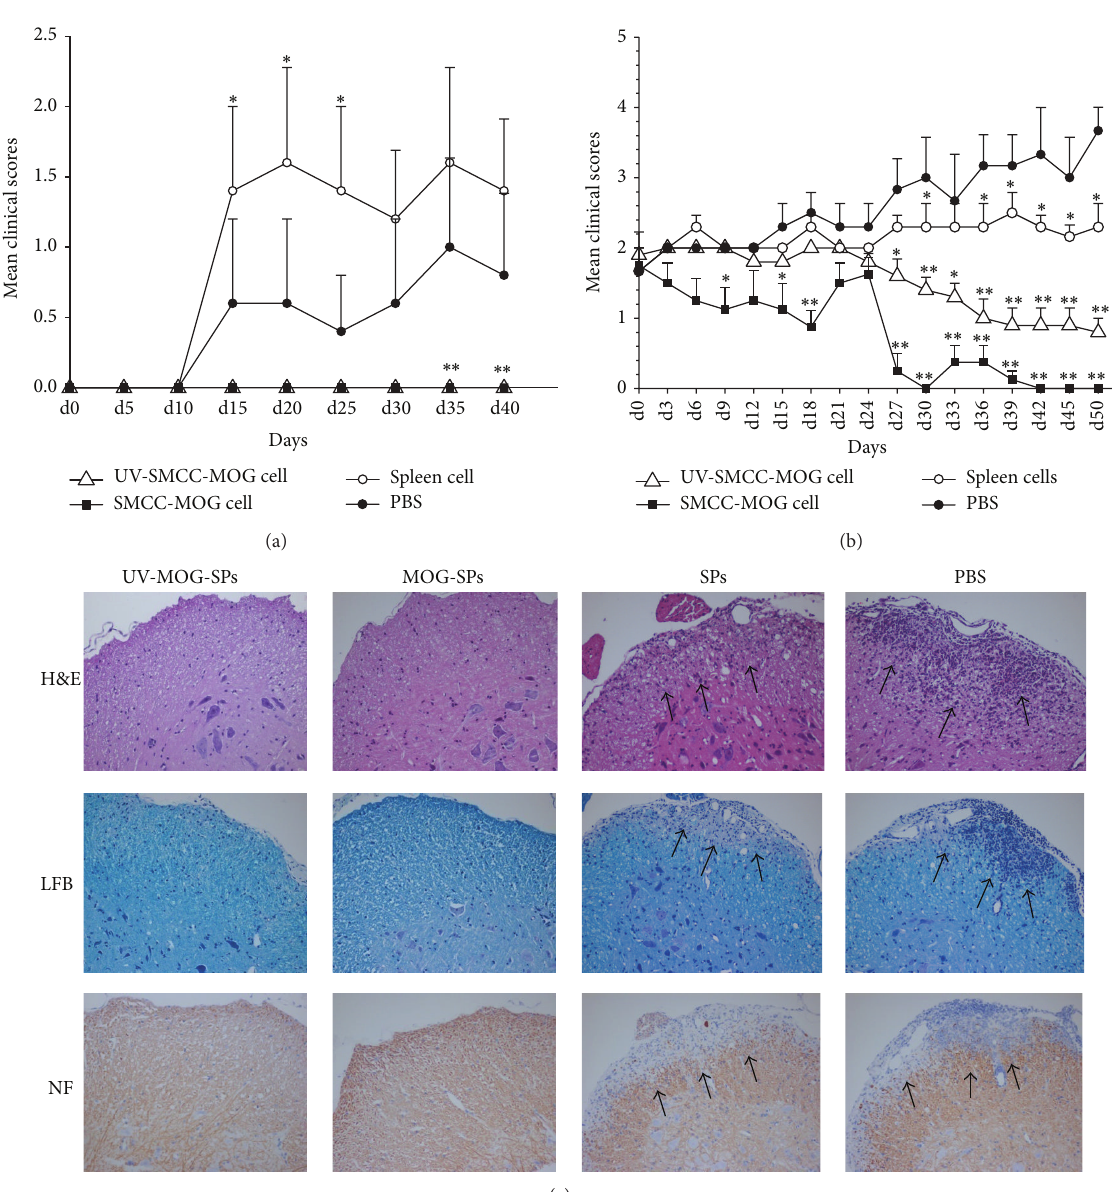
Figure 2: Infusion of MOG-coupled spleen cells reverses clinical EAE. (a) Na¨ıve C57BL/6 mice were immunized as in Figure 1. Around one week before EAE onset, mice were randomly divided into four groups (UV-MOG-SPs, MOG-SPs, SPs, or PBS control, 5 mice/group) and given 1 × 10 7 different cells or the same volume of PBS for 5 times (days 5, 10, 15, 20, and 23). The scores of treatment groups were compared to the scores of PBS treated group at each time point. ∗ 𝑝 < 0.05 ; ∗∗ 𝑝 < 0.01 . (b) A cohort of mice was monitored after EAE induction. When the clinical score reached 2 or above, the EAE mice were randomly divided into four groups (5 mice/group): UV-MOG-SPs, MOG-SPs, SPs, or PBS. The mice in different groups received corresponding treatments twice a week for three weeks. The scores of treatment groups were compared with the scores of PBS treated group at each time point. ∗ 𝑝 < 0.05 ; ∗∗ 𝑝 < 0.01 . (c) Sections from the spinal cords of EAE mice in late reversal experiments on day 50 (4 mice/group) were stained with H&E for inflammatory infiltrates (upper panel), LFB for demyelination (middle panel), and NF staining for axonal loss (bottom panel). Original magnification × 20. The arrows indicate areas of lesion with infiltrated cells, demyelination, and axonal loss. One representative animal of each group was exhibited. Similar results were obtained from two additional independent